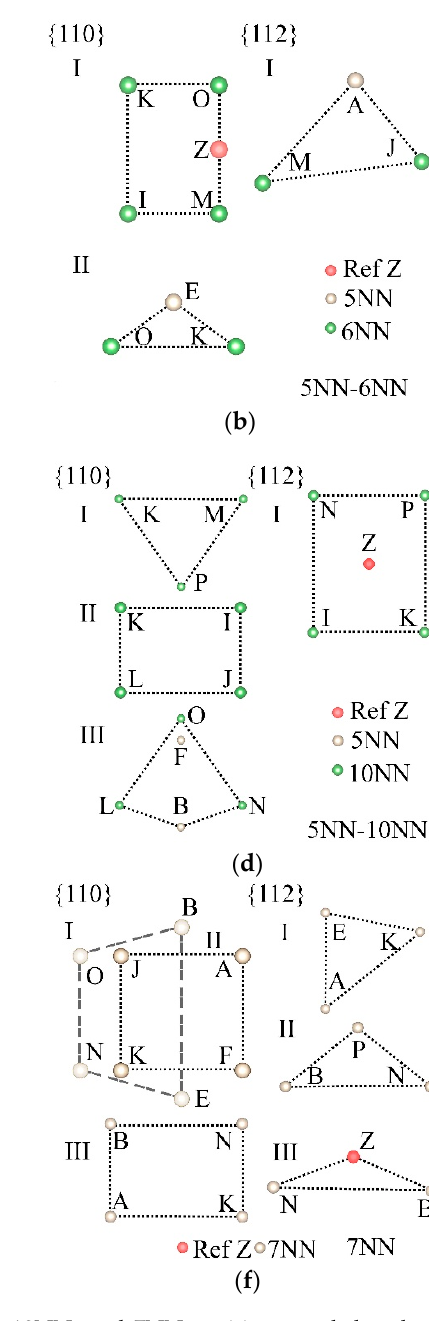
Figure 8. A selected reference site Z, its 5NN, 6NN, 10NN, and 7NN positions, and the planes decided by them in the α -Fe single crystal. ( a ) The 5NN and 6NN positions of Z (s 5NN-6NN ) and the maximum density planes of them. ( b ) Two types of {110} and one type of {112} plane decided by s 5NN-6NN . ( c ) The 5NN and 10NN positions of Z (s 5NN-10NN ) and the maximum density planes of them. ( d ) Three types of {110} and one type of {112} plane decided by s 5NN-10NN . ( e ) The 7NN positions of Z (s 7NN ) and the maximum density planes of them. ( f ) Two types of {110} and three types of {112} planes decided by s 7NN , in which the type I and II planes of {110} are parallel but with different shapes. Table 4. The {110} and {112} planes decided by the s 5NN-6NN , s 5NN-10NN , and s 7NN as well as the selected reference hydrogen atom Z.